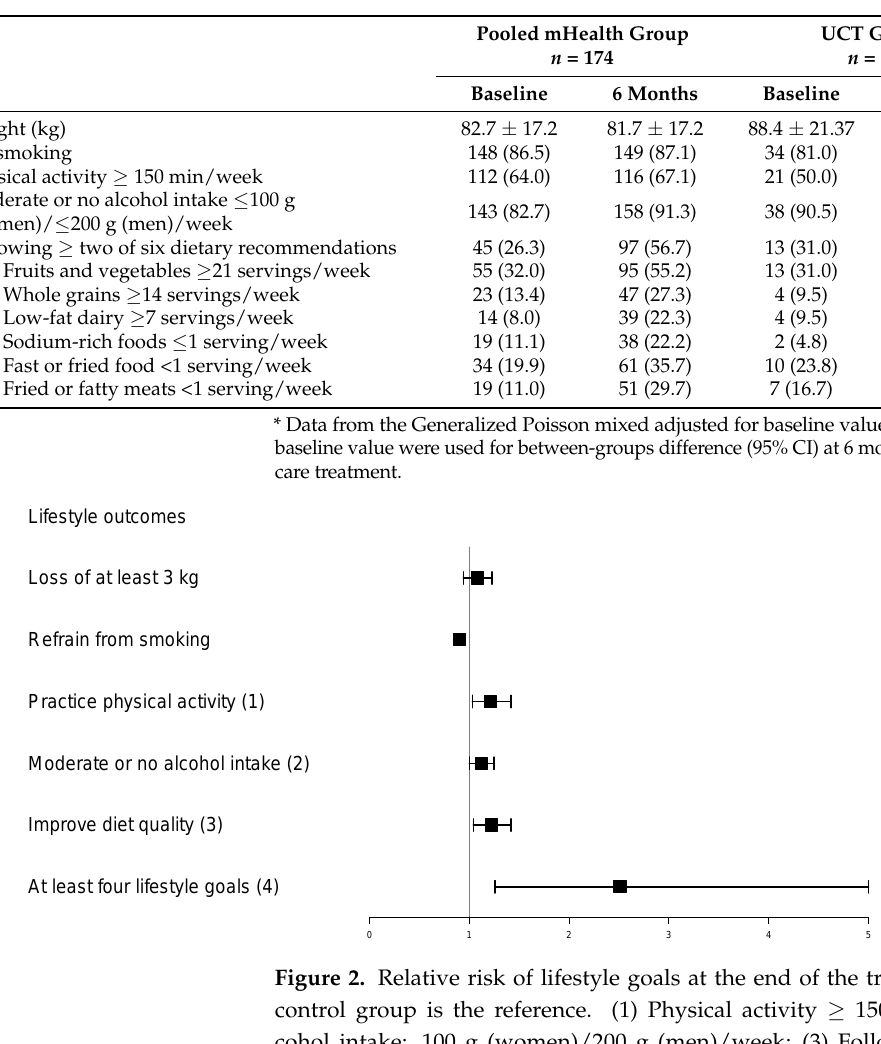
Table 2. Relative risk (95% CI) for achieving the lifestyle goals at the end of the trial by intervention groups, adjusted for baseline values.